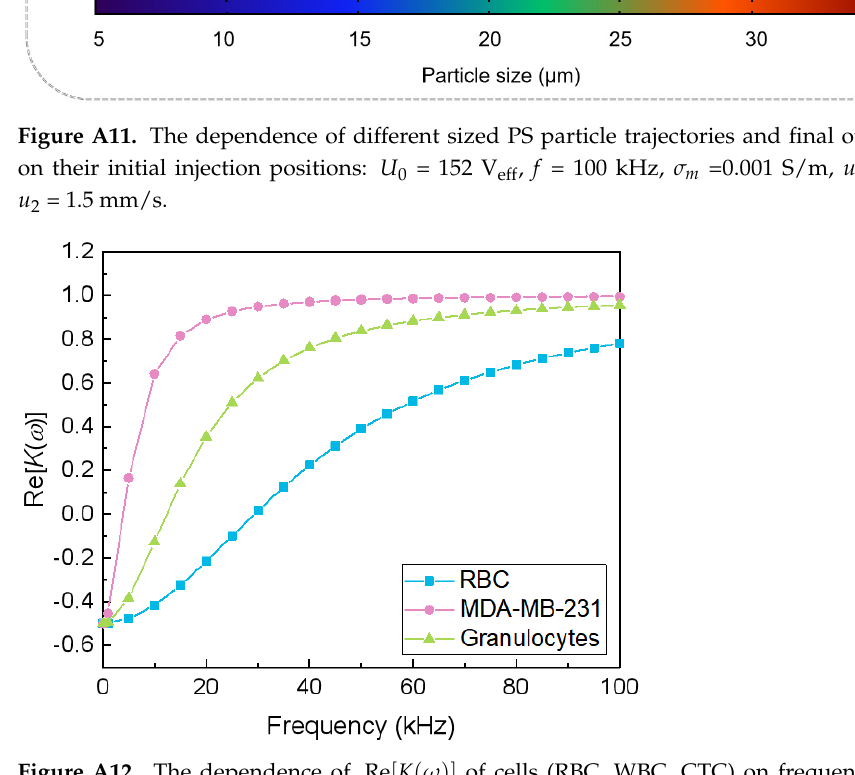
Figure A13. Distribution of heat flow in hybrid floating cIDE separator under zero initial velocity ( 𝑢 (cid:2869) = 0, 𝑢 (cid:2870) = 0). Figure A14. The trajectory of RBCs and MDA-MB-231 with temperature distribution as the back- ground: U 0 = 62 V eff , 𝒖 𝟏 = 1.4 mm/s, 𝒖 𝟐 = 1 mm/s, f = 20 kHz, 𝝈 𝒎 = 0.002 S/m: ( a ) Only under the action of DEP force; ( b ) Only under the influence of heat flow; ( c ) Under the combined action of DEP force and heat flow. References 1.